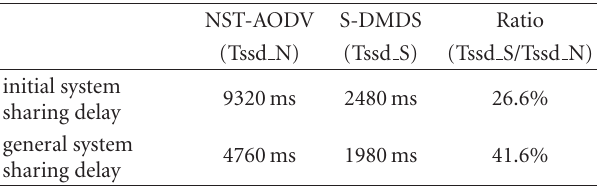
Table 4: Simulation result of system sharing delay in mobile